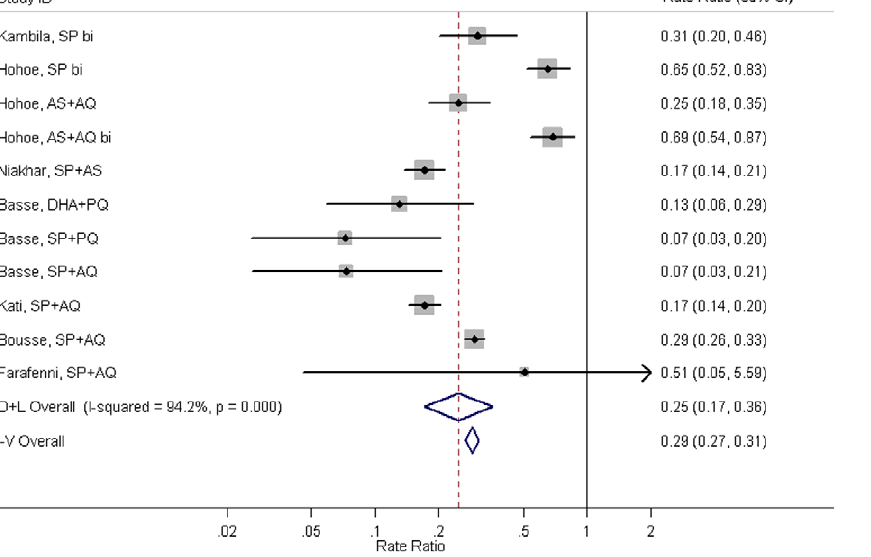
Figure 2. Effect of IPTc on clinical malaria (any level of parasitaemia) during the intervention period. NOTE: D + L Overall=Random effect meta-analysis, I–V Overall=Fixed effect meta-analysis. AQ: amodiaquine, AS: artesunate, bi: bimonthly administration, CI: confidence interval, DHA: dihydroartemisinin, PQ: piperaquine, SP: sulphadoxine pyrimethamine. doi:10.1371/journal.pone.0016976.g002 PLoS ONE |